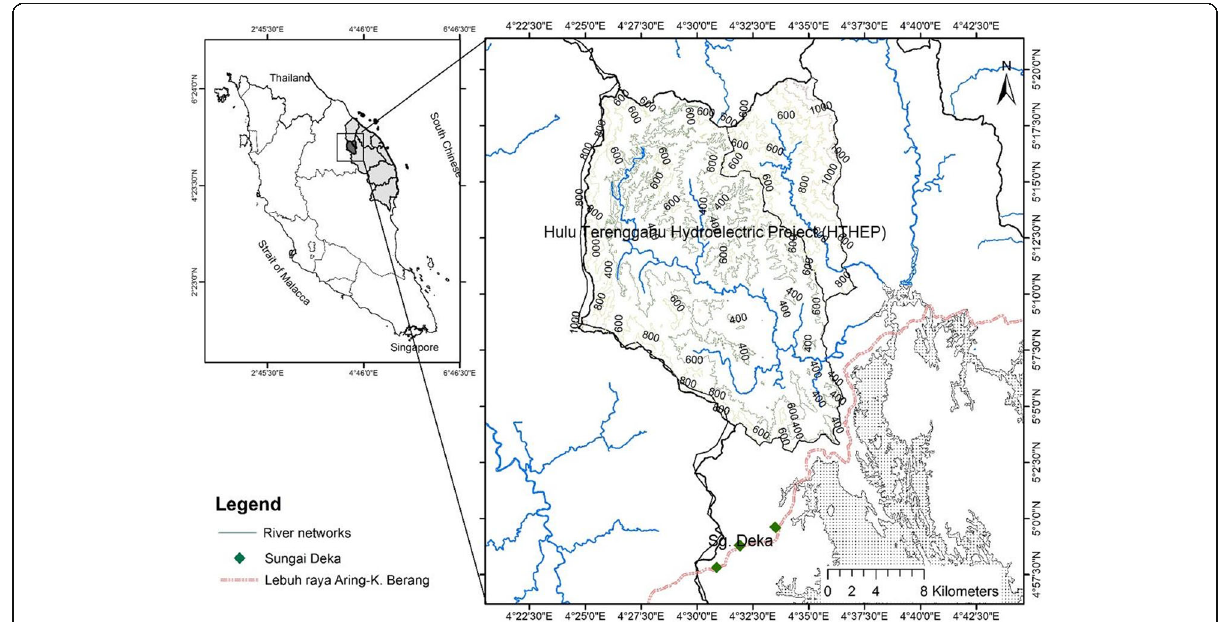
Fig. 1 The location of study site: Hulu Terengganu Hydroelectric Project (HTHEP), Terengganu, Peninsular Malaysia. The inset map shows the pre- inundation phase of Puah Catchment area with tributaries is still